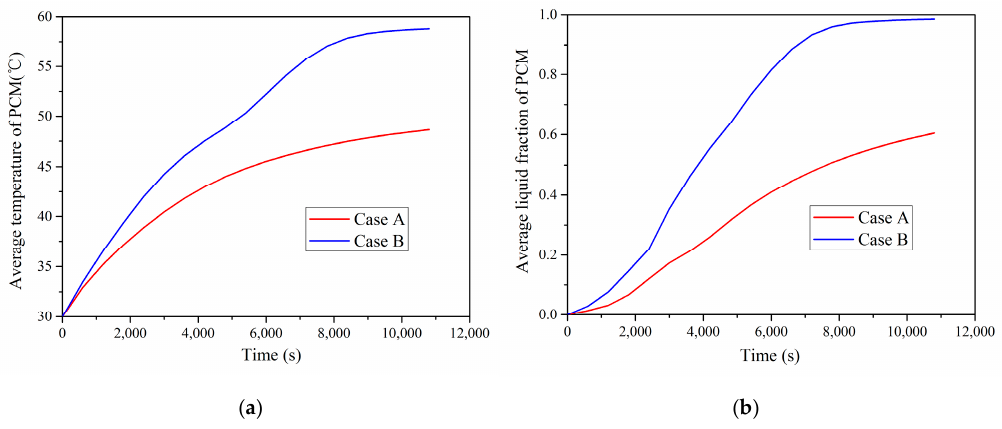
Figure 11. ( a ) Average temperatures of PCM over time; ( b ) Average liquid fractions of PCM over time.